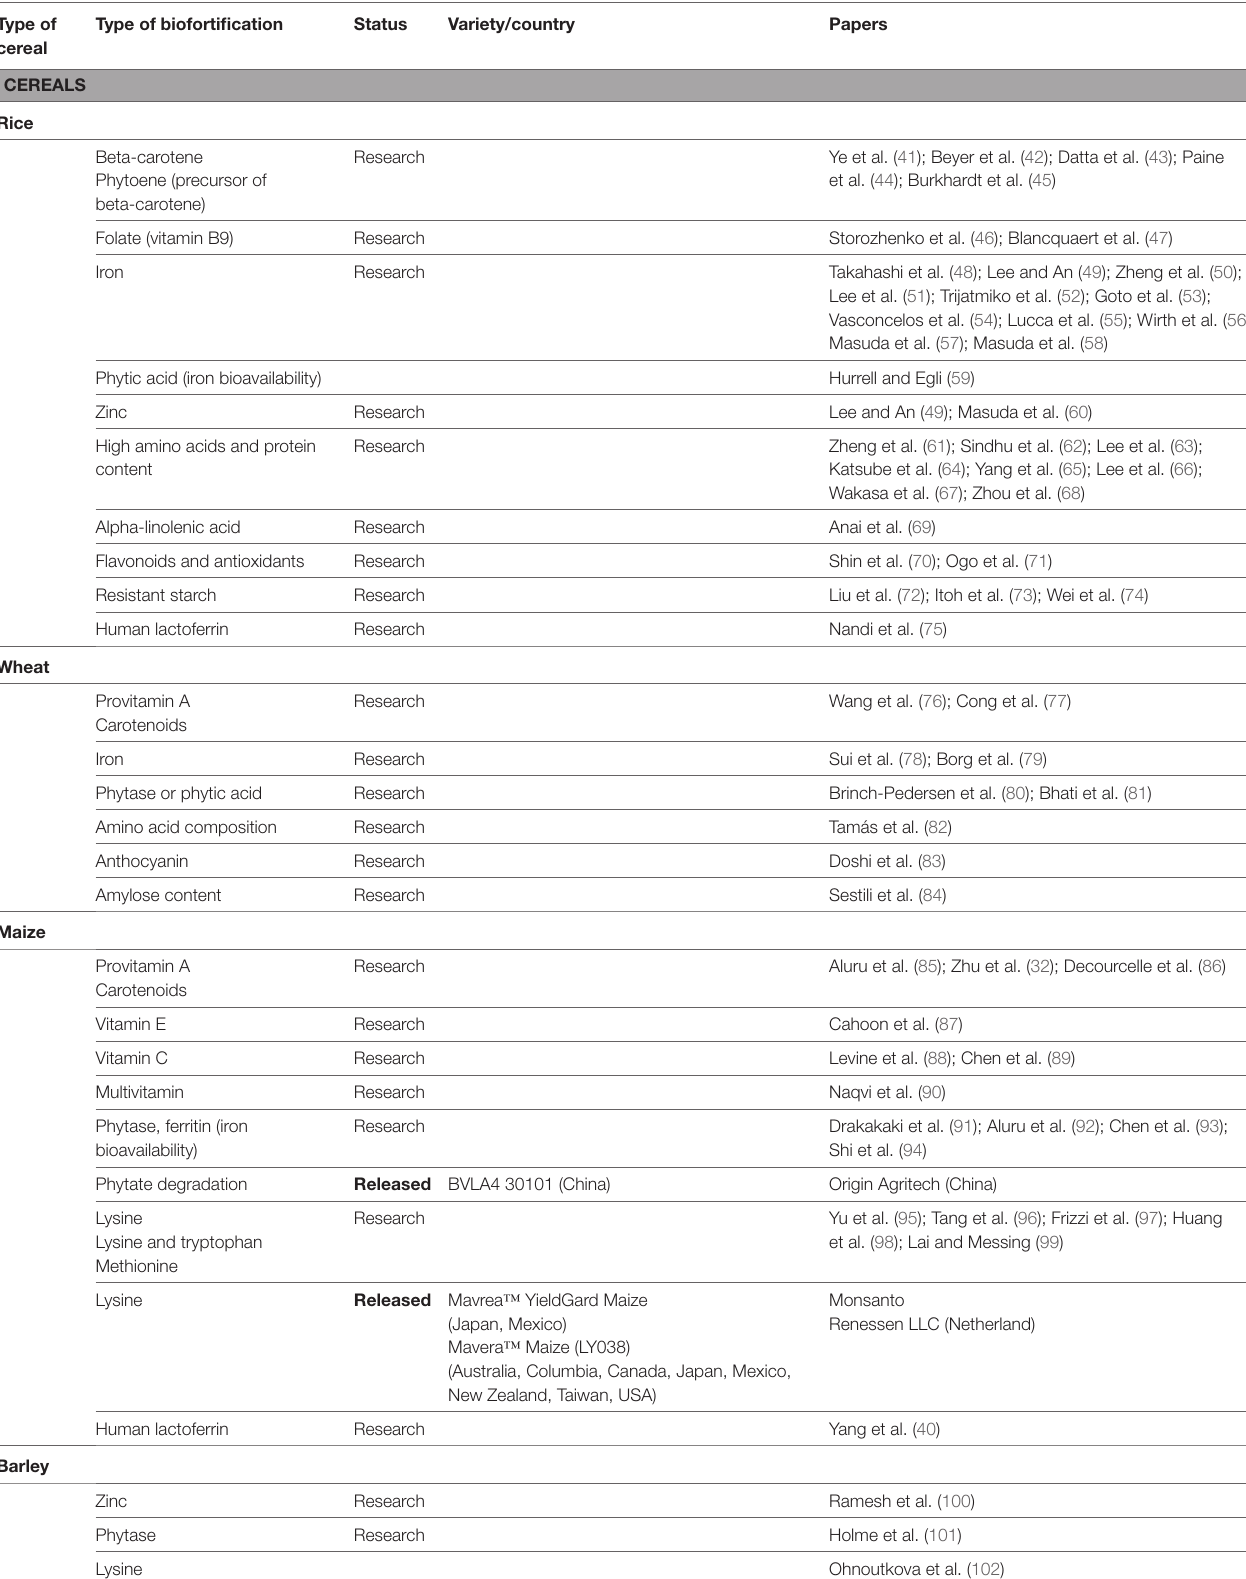
TABLe 2 | Tabulation of crops, nutrients, research status, and concerned publications on biofortification by transgenic